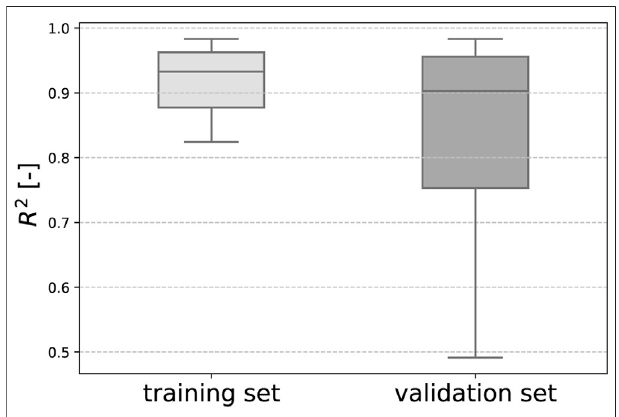
FIGURE7| OurtrainedviscoelasticCANNscouldreproducethestress- strain curves in the training data with a median coef fi cient of determination R 2 (cid:2) 0.94 and predict such curves for the validation samples with a median R 2 (cid:2) 0.90 in a LOO-CV